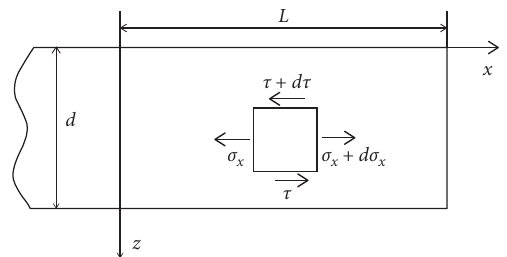
Figure 9: A schematic of the stresses on the element in the horizontal